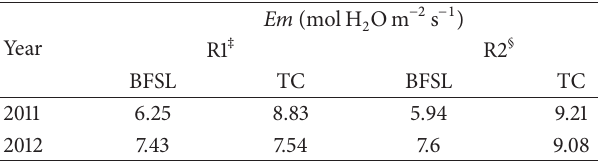
Table 4: Mean Em at growth stages R1 and R2 of 10 irrigated maize hybrids grown on a Bosket fine sandy loam (BFSL) and a Tunica clay soil in 2011 and 2012 near Stoneville, MS † .